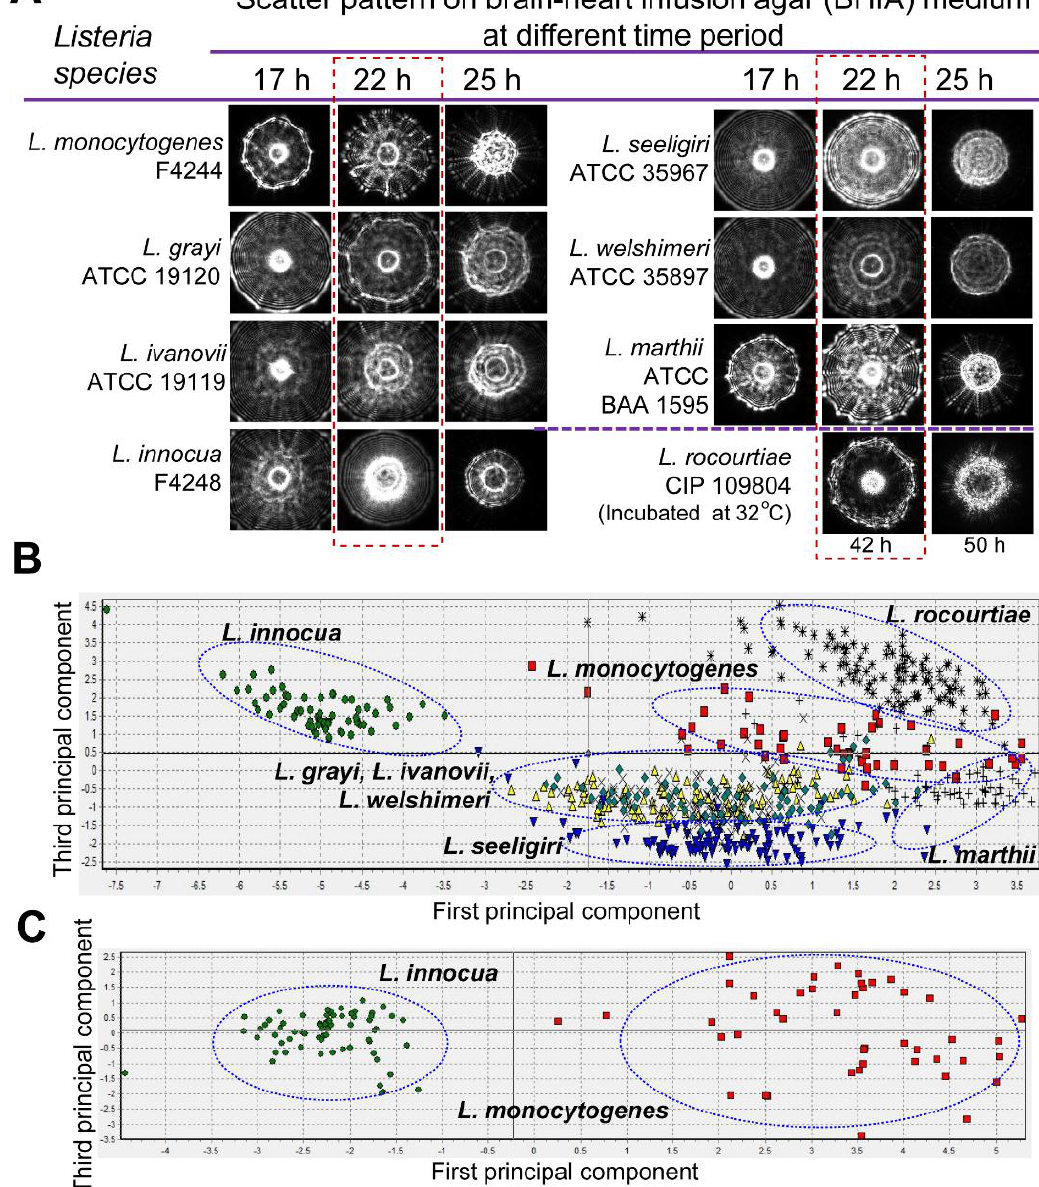
Figure 4. Optical scatter patterns of Listeria species and image analysis. ( A ) Colony scatter patterns were captured using BARDOT at different incubation times for eight Listeria species on BHI agar plates. Rectangular selection with broken line depicts the optimal incubation time (22 h) that yielded differentiating scatter images when the colony size was 1.1 ± 0.2 mm diameter; ( B ) Principal component analysis of the eight Listeria species used to build the scatter image library. Blue oval selections indicate grouping of the Listeria species; ( C ) Principal component analysis of L. monocytogenes and L. innocua colony scatter images that were used to build a two-species scatter image library. The blue oval selections indicate grouping of each Listeria